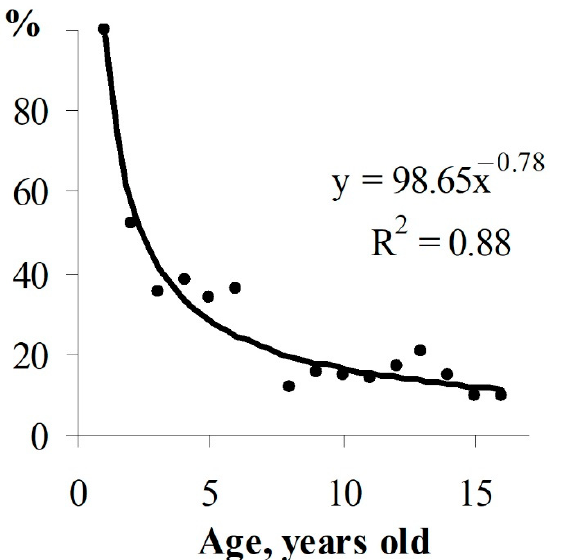
Figure 2. Empirical survival curve of the Pinus sibirica undergrowth from the initial number of seedlings (%) in the mountain tundra.